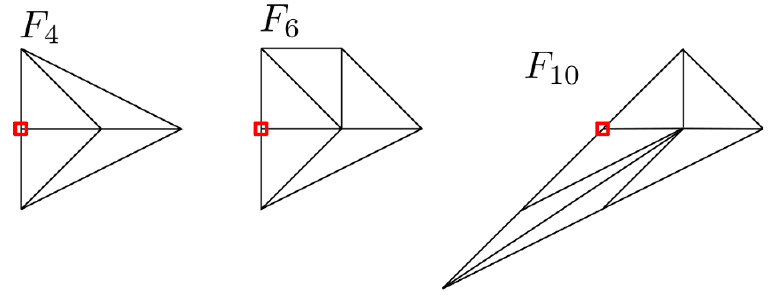
Figure 7 . Fibers of the Higgs chain Z 2 U(1)